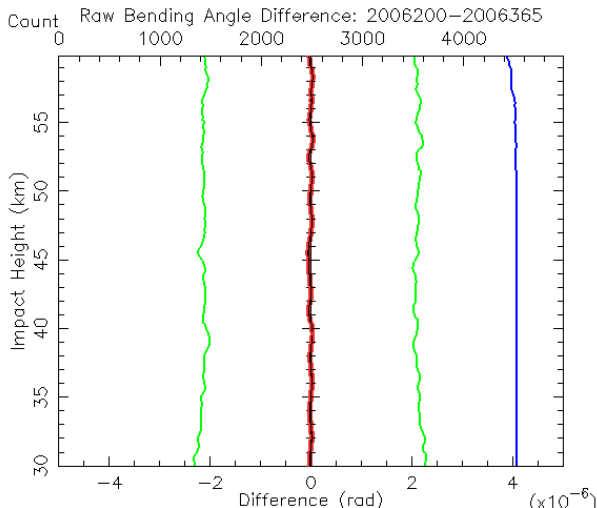
Fig. 21. Statistical comparison of fractional bending angle dif- ferences as a function of impact height for global collocated Metop/GRAS and